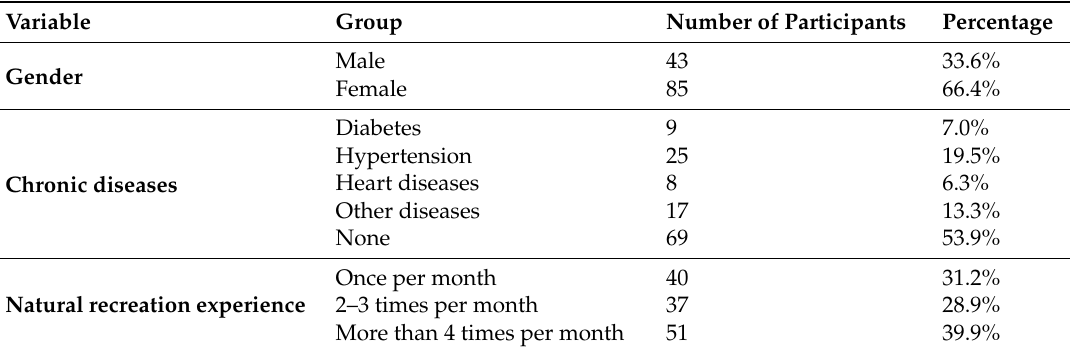
Table 1. Summary of sample characteristics (N =